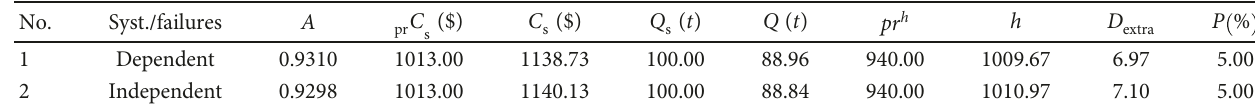
Table 2: Availability, cost, and capacity of the system.